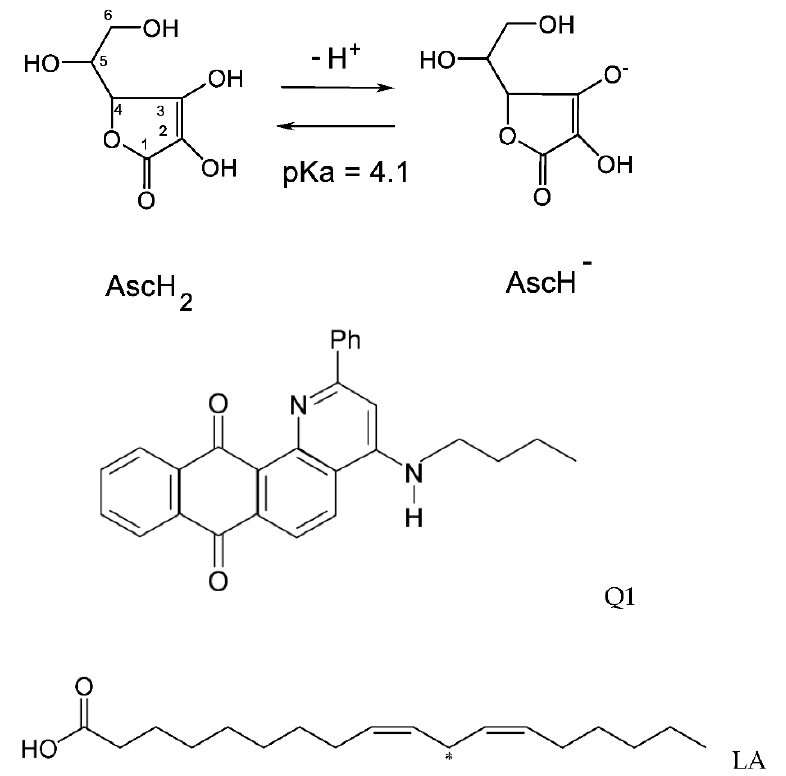
Figure 1. Structures of ascorbic acid (AscH2), quinone-chelator Q1: (2-phenyl- 4-(butylamino)naphtho[2,3-h]quinoline- 7,12-dione)), and linoleic acid (LA).